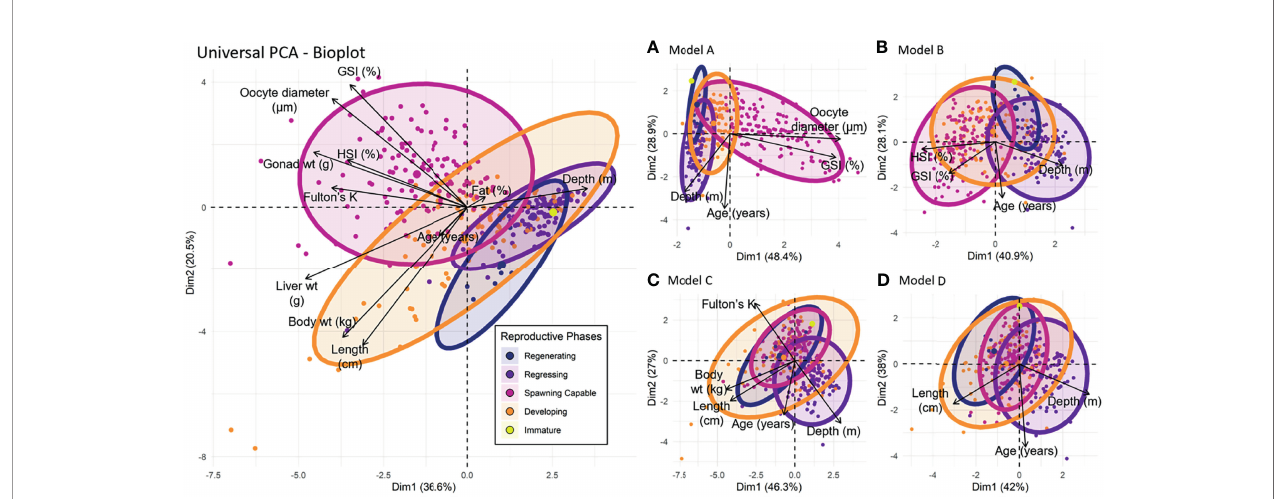
FIGURE 8 | Principal component analysis (PCA) biplot of biological indices grouped by reproductive phase of female Paci fi c halibut. The x-axis represents the fi rst principal component (PC1) and the y-axis represents the second component (PC2). Together they account for 57.1% of the total variance observed in the data. Side panels (A-D) are PCA biplots of the best models (model A-D) developed from survey variables constrained by logistical sampling challenges and are useful visual keys to how the proposed model parameters interact with each other as well the separation of phases within each